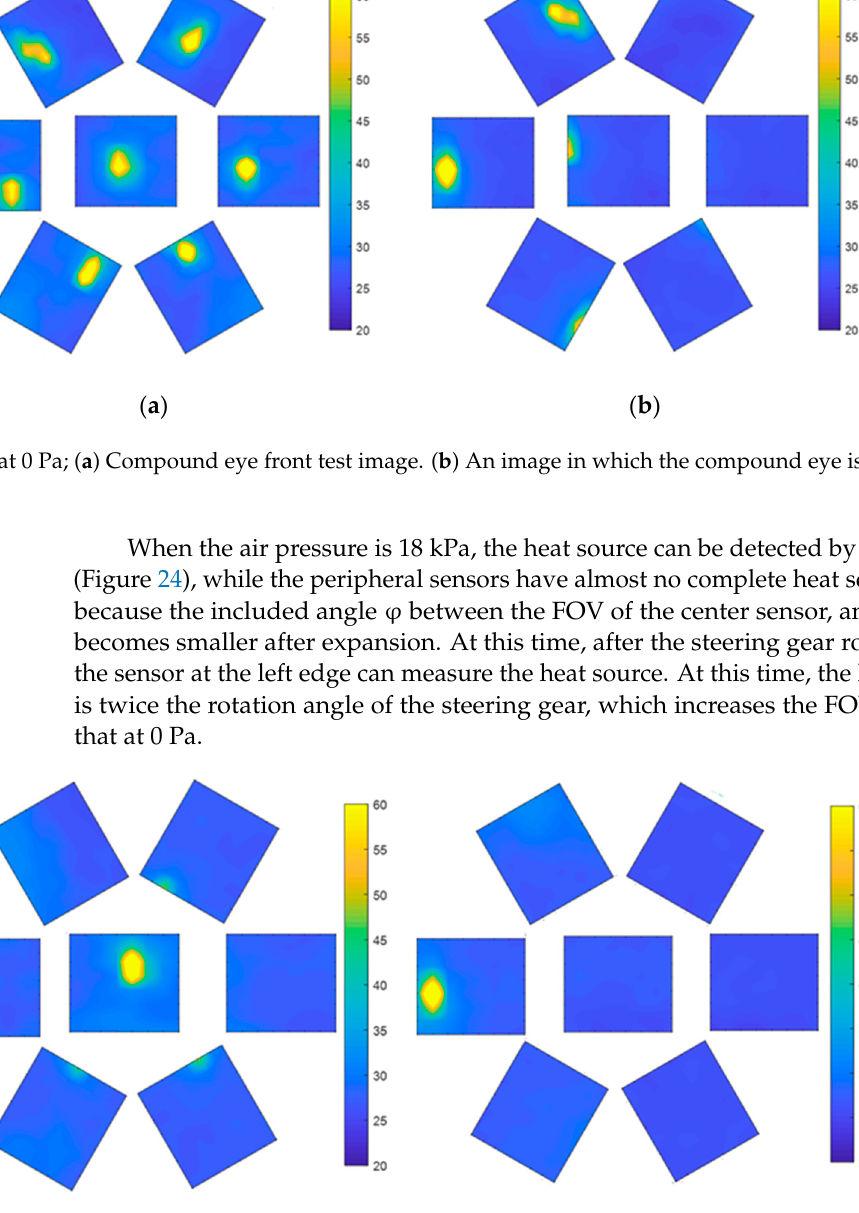
( b ) Figure 25. FOV test at 36 kPa. ( a ) Front test image of compound eye. ( b ) Test image of the compound eye rotated to the edge of the FOV. A comparison of Figures 23a, 24a and 25a shows that the heat source of the central eyelet sensor is amplified in the assembly, which is caused by the height change in the central eyelet of the compound eye during the expansion process. The experimental results indicate that VSICE has a large enough angle range to adjust the FOV. By controlling the air pressure, VSICE can quickly convert a small FOV to a large FOV, stably read the array data under a large FOV, and can convert the planar compound eye to a curved compound eye. As the carrier is an SAM, the process of changing the FOV is reversible, which proves that SASCE can adapt to a variety of complex situations.